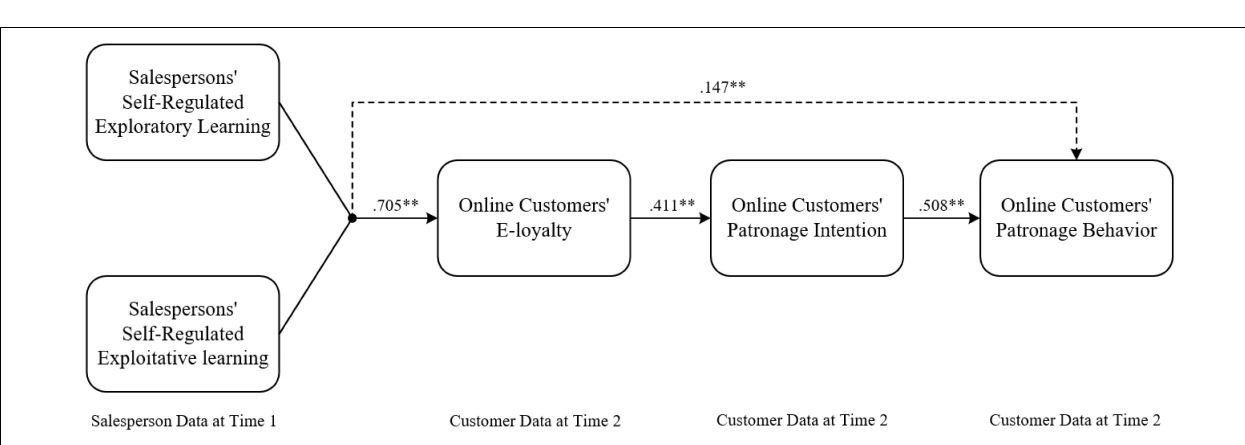
FIGURE 1 | Hypothesized response surface graphs. The line of imbalance is depicted with the dotted line along the floor of the graph.